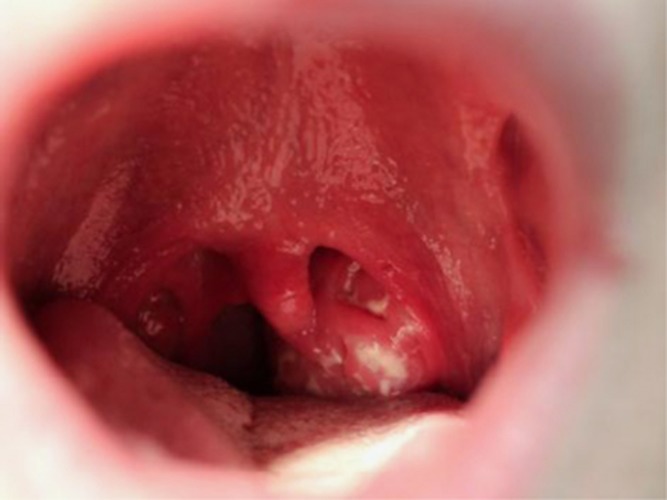
Pharyngitis demonstrating exudative tonsillitis and an enlarged uvula in a 19-year-old undergraduate university student 5 days after onset of infectious mononucleosis. In addition to pharyngitis, he felt febrile, had cervical lymphadenopathy, fatigue and loss of appetite. His sore throat lasted for 9 days and he was fatigued for 29 days.